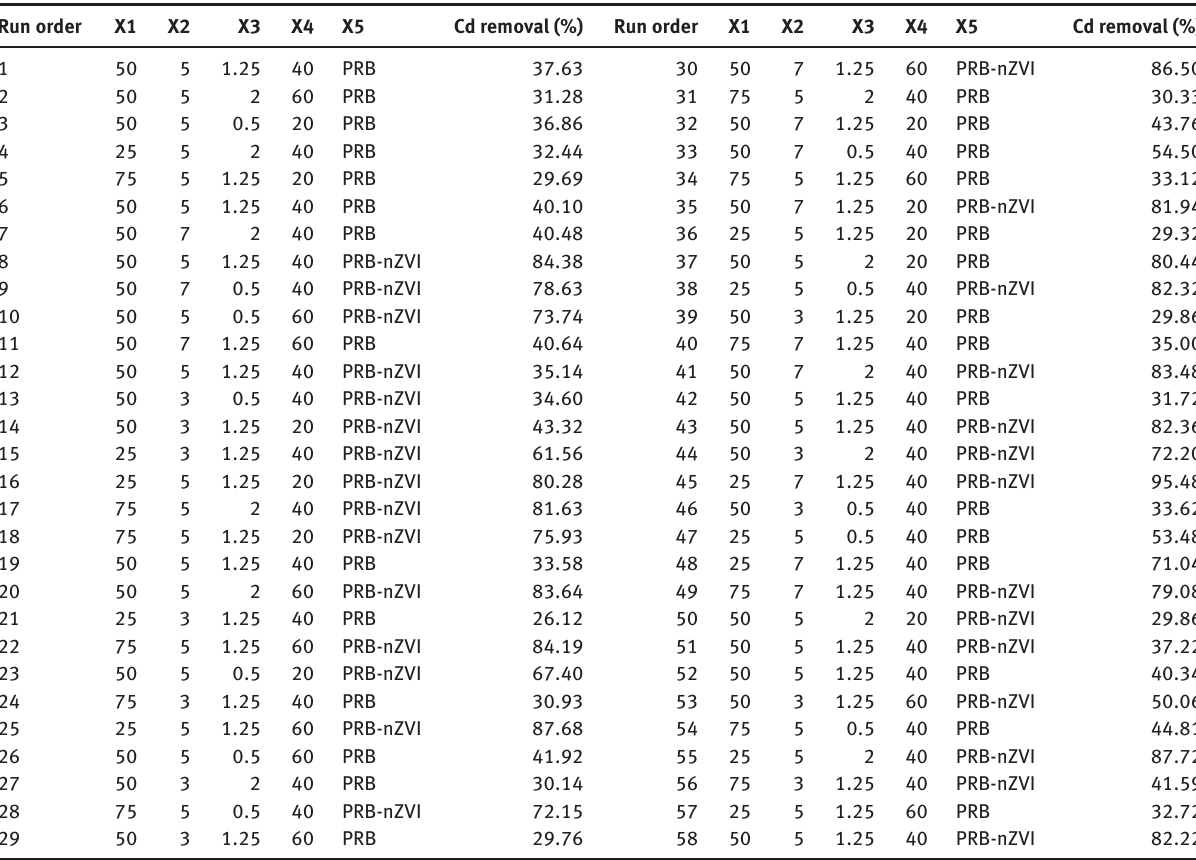
Table 2: Experimental design based on BBM used in this study. Run